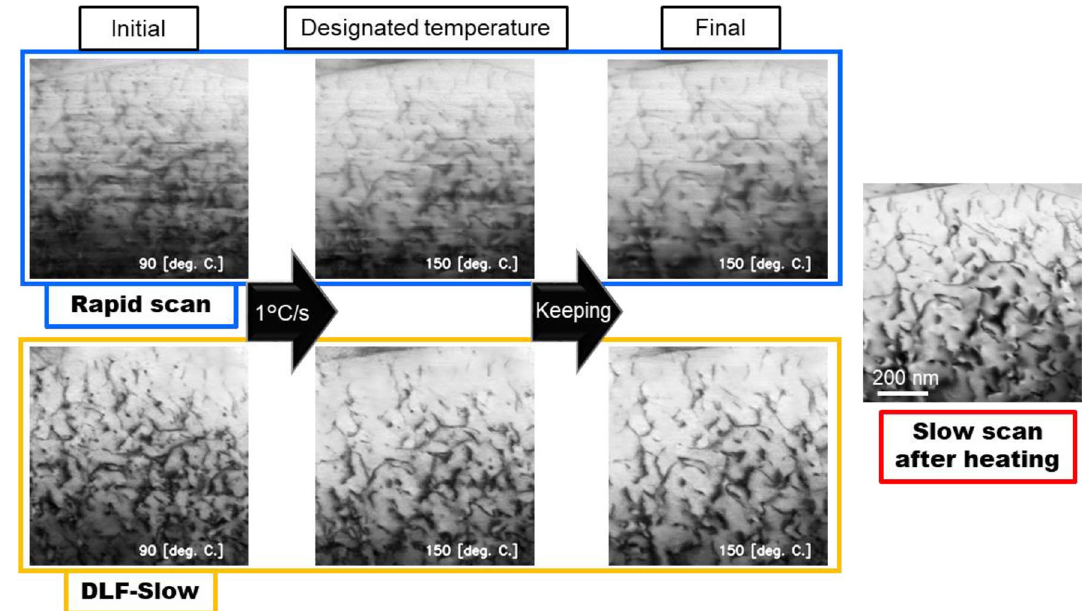
Figure 5. Application of DL-based noise filter to in-situ heating of 20%-cold-rolled pure poly aluminum (A1050). The specimen was heated in a rate of 1 °C/s, then the temperature was kept constant after reaching designated temperature. The heating process from 90 °C to 150 °C is shown here as an example. Other heating processes are represented in Supplementary information Fig. 1d. During the training process, the DL network is trained so that it reproduces the slow scan images from the corresponding rapid scan images. The transformation function to modify the difference in background